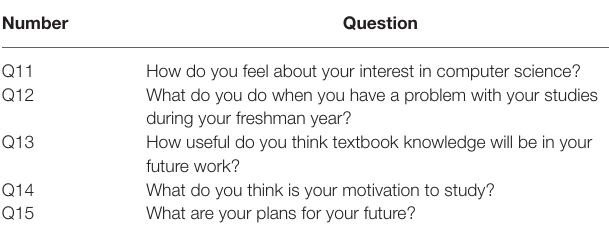
TABLE 5 | Questions about learning motivation.